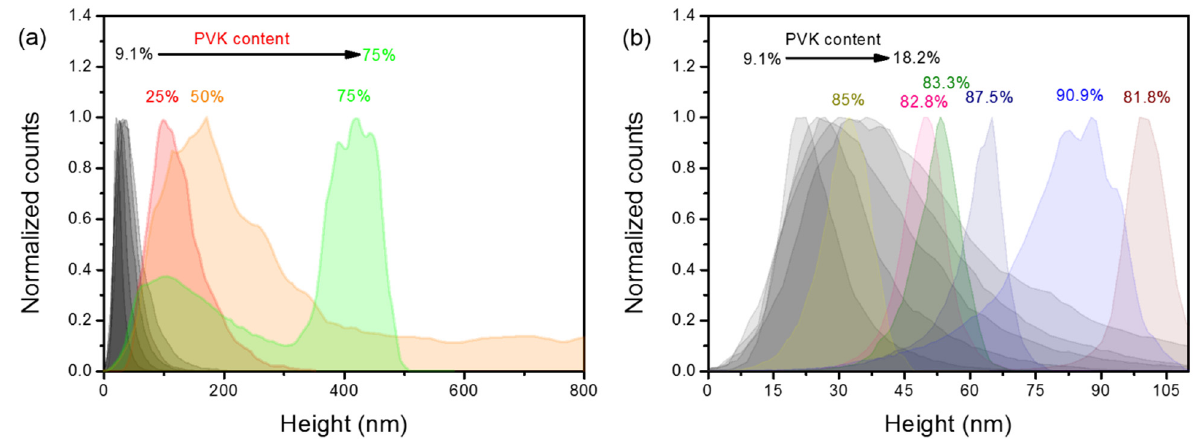
Figure 3. Normalized height histograms for different concentrations of PVK in PMMA:PVK blends; ( a ) the histograms for an increasing amount of PVK from 9.1 to 75%; ( b ) the comparison of height histograms for samples containing 9.1–18.2 and 81.8–90.9% of PVK.